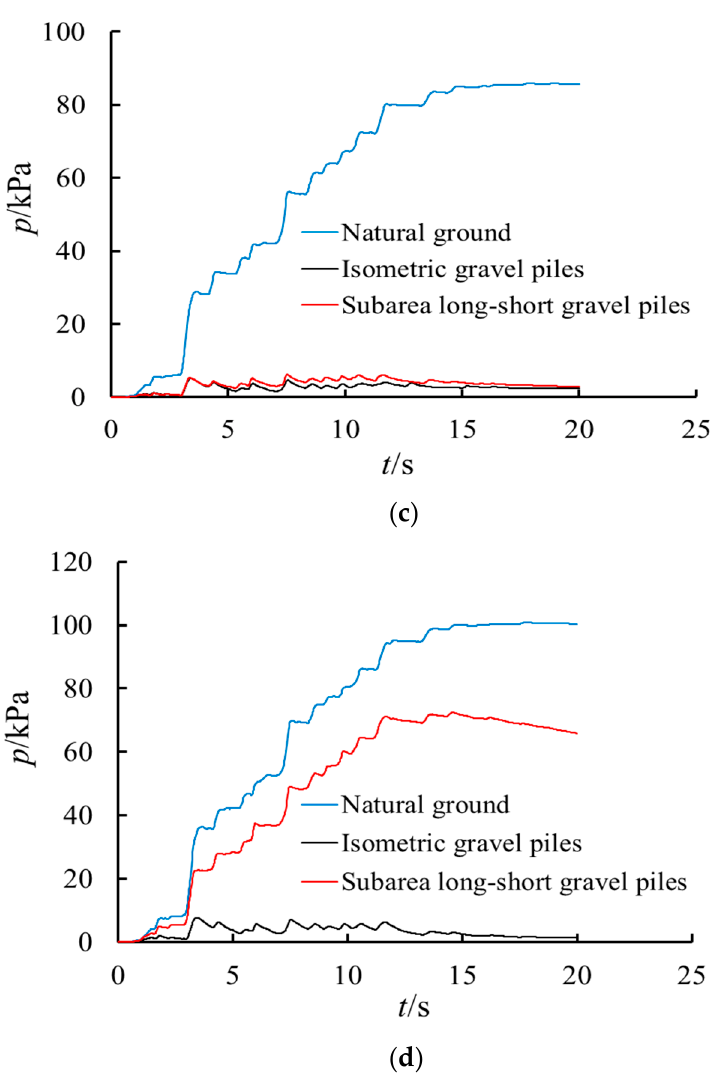
Figure 11. The time history curves of dynamic pore pressure in natural foundation and reinforced foundations. ( a ) P1. ( b ) P2. ( c ) P4. ( d ) P5.